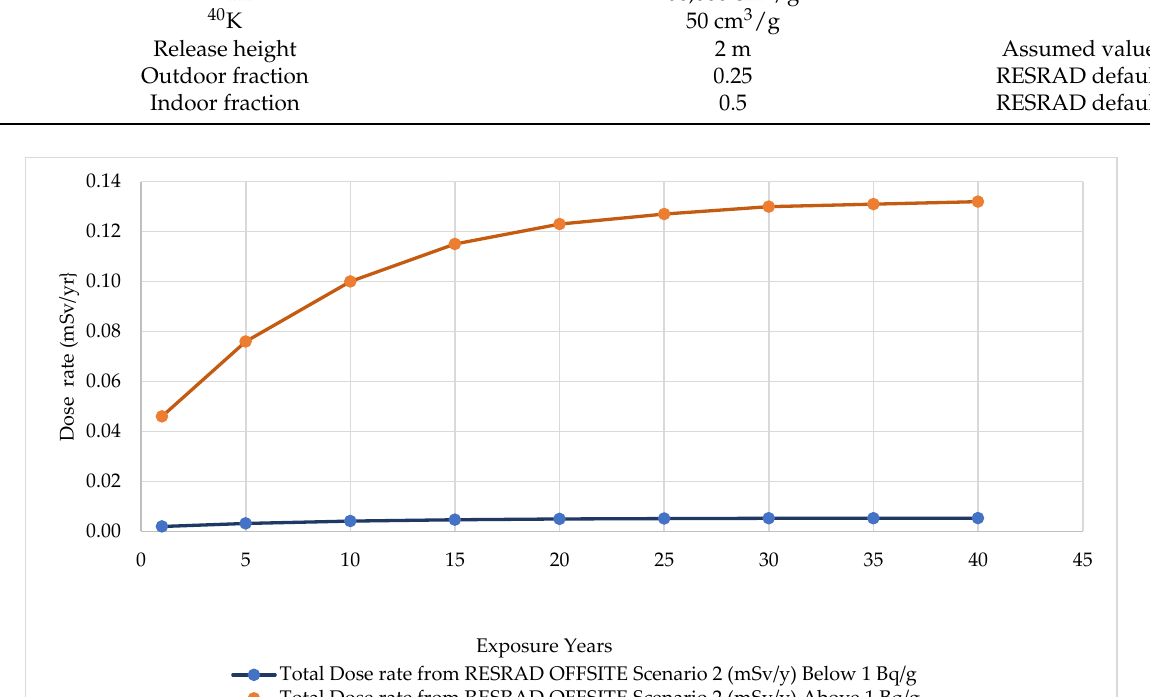
Figure 5. Dose from the RESRAD-OFFSITE scenario.